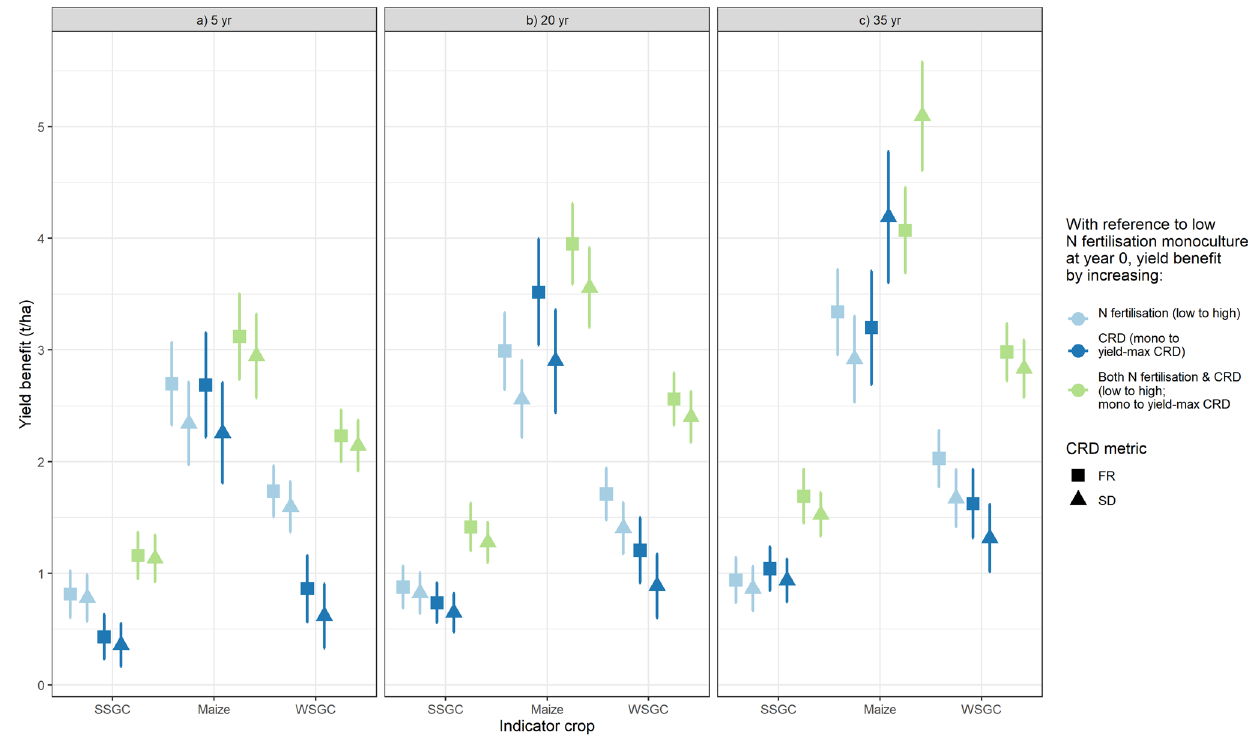
Fig. 3 Comparison of yield bene fi ts from increasing either crop rotational diversity (CRD), external nitrogen (N) fertilization or both over time. Mean (±95% CI) yield bene fi ts, with reference to monocultures at year = 0 receiving low external N inputs, from only increasing N fertilisation to high (maintaining monocultures; light blue), only increasing CRD to yield-maximising CRD (maintaining low N fertilisation; dark blue) and increasing both N fertilisation (from low to high) and CRD (from monoculture to yield-maximising CRD; green). The three time periods represent the a early-, b middle- and c long-term effects of time within our range of data. The yield bene fi t estimates were derived from the fi tted models for both CRD metrics, i.e., functional richness (FR; the number of functional groups included in the rotation; squares) and species diversity (SD; based on the inverse Simpson ’ s diversity index; triangles), for each group of indicator crops, i.e., spring small grain cereals (SSGC), maize and winter small grain cereals (WSGC). Predictions were derived from mean-centred observations i.e., the difference from to the long-term within-site average across all CRD treatments, after 5, 20, and 35 years since the beginning of the experiment. Yield-bene fi t of 0 indicates model predictions remained the same, negative values are yield losses and positive values are yield bene fi ts compared with yields in monocultures at year =